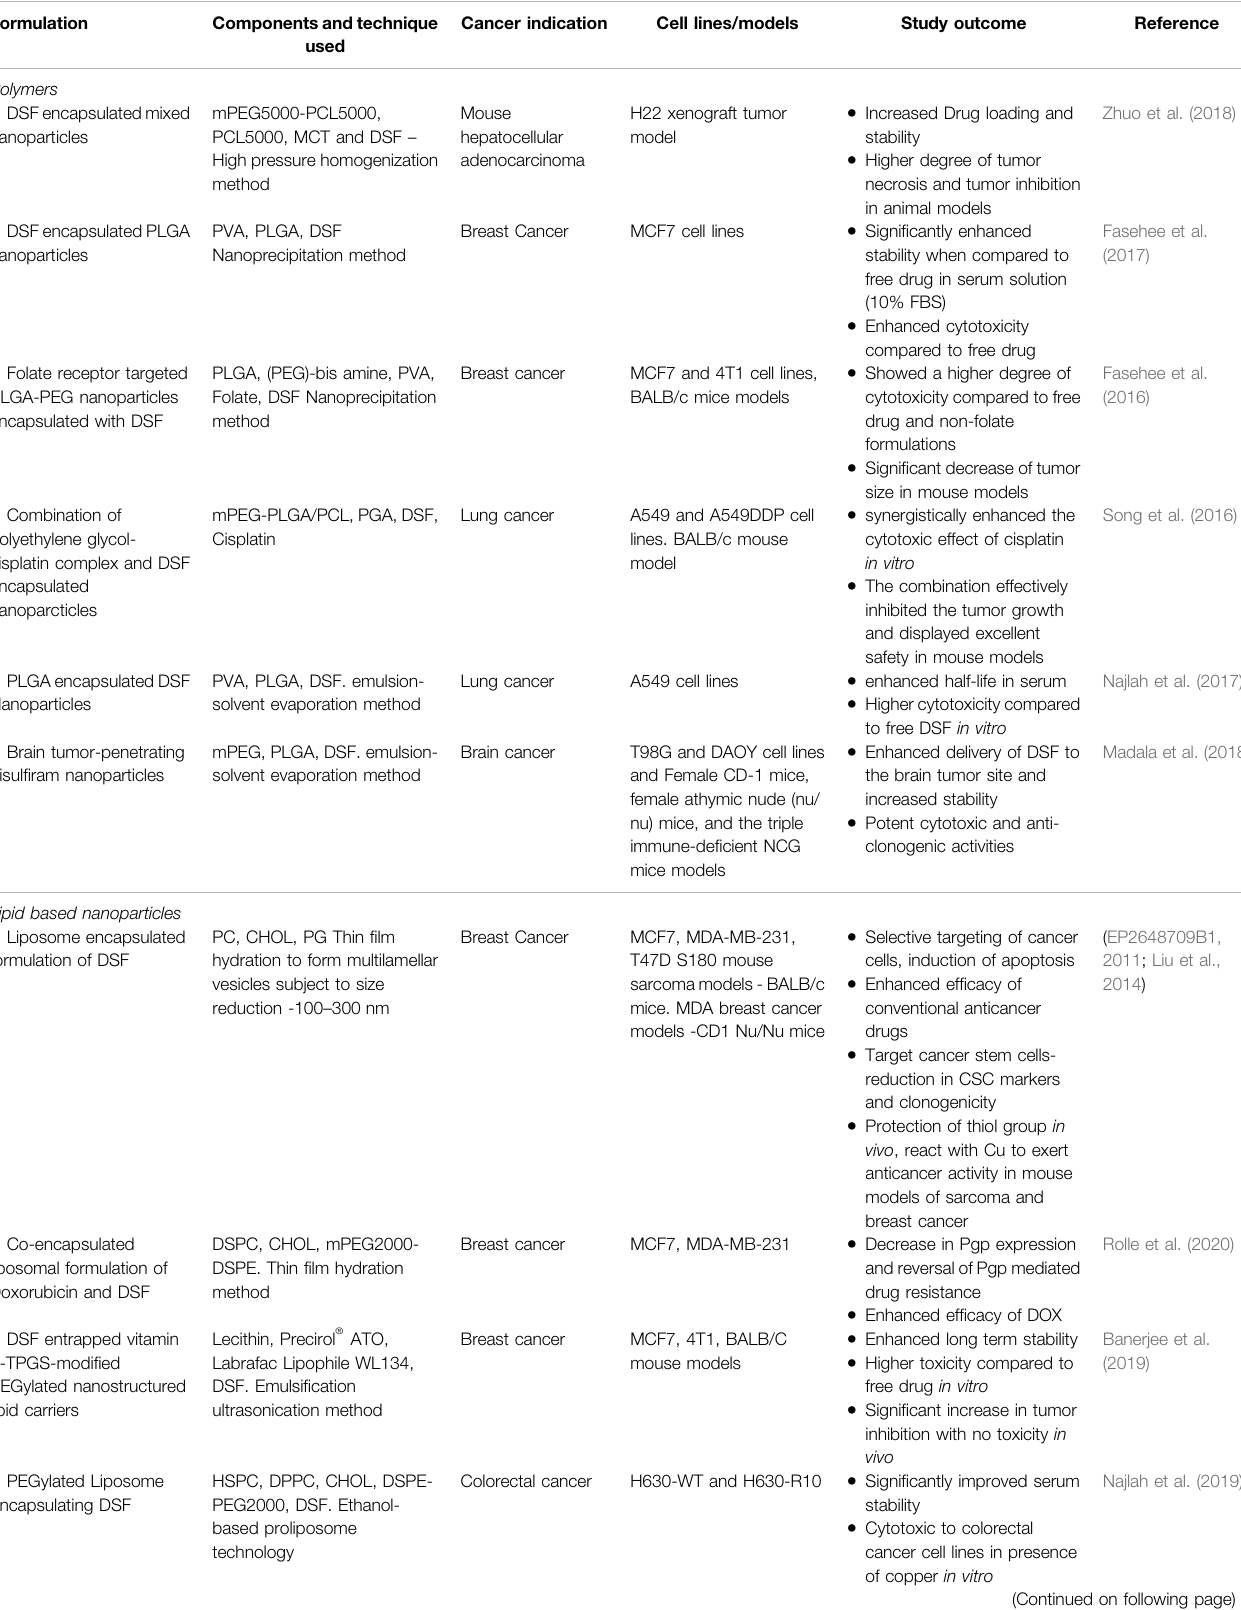
TABLE 3 | Formulation strategies used for delivery of disul fi ram for cancer